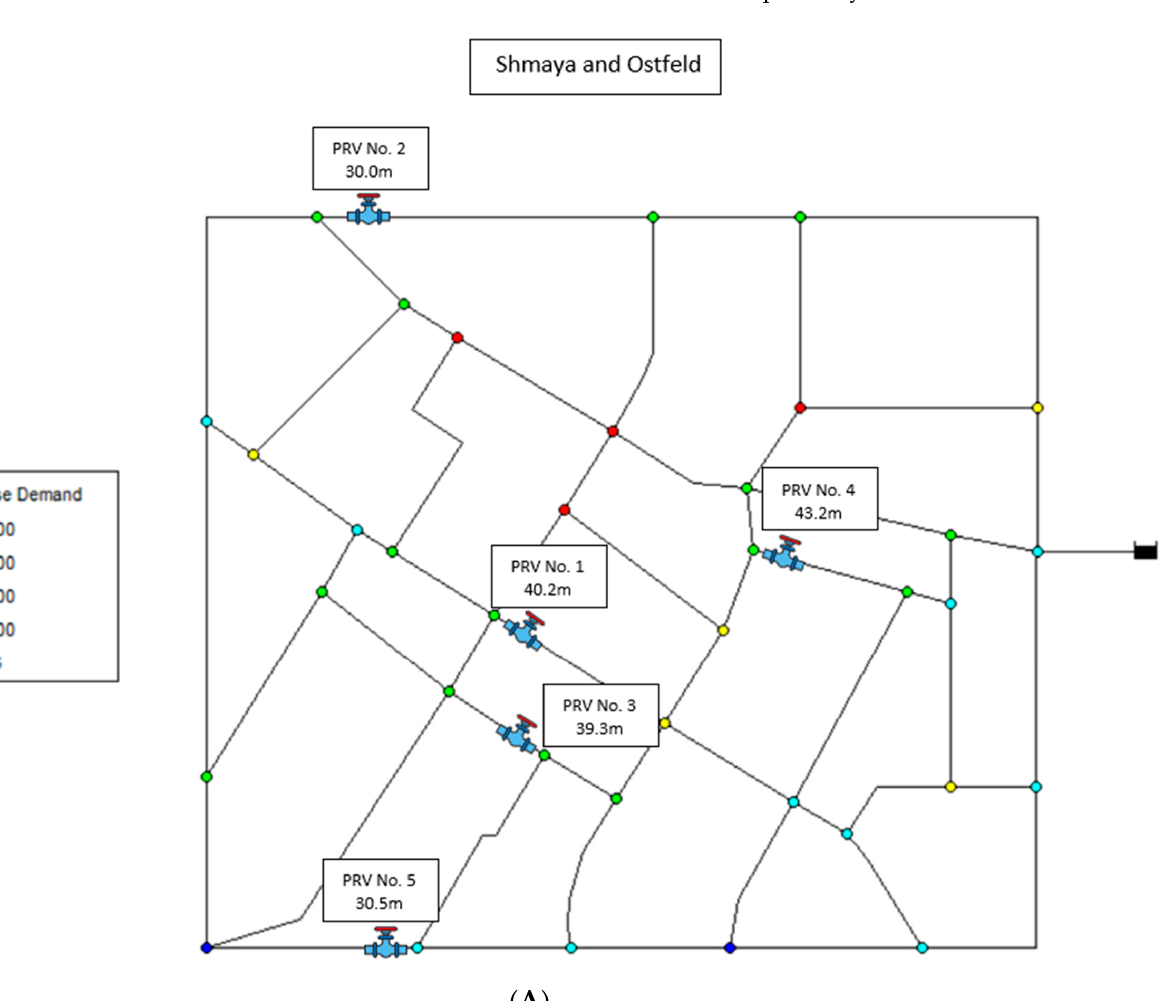
Figure 7A,B present the results of applying Shmaya and Ostfeld’s method and Price and Ostfeld’s method on the Fossolo network, respectively.